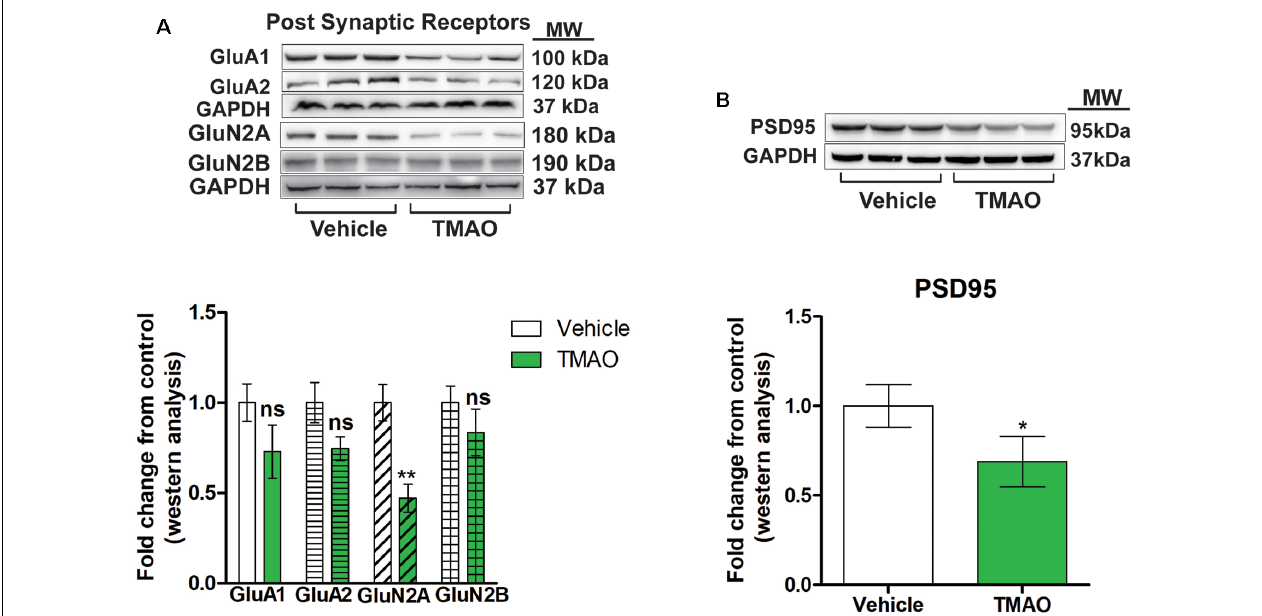
FIGURE 4 | TMAO induces changes in post-synaptic receptor subunits. (A) Representative western blot showing GLuA1, GLuA2, GLuN2A, and GLuN2B relative levels normalized to GAPDH in slices treated lysates. (B) Representative western blot showing PSD95 relative levels normalized to GAPDH. Symbols/bars represent mean ± SEM; *indicates significant difference between vehicle vs. TMAO treated slices, * p < 0.05, ** p < 0.01; n = 3 mice per group. ns, non-significant.